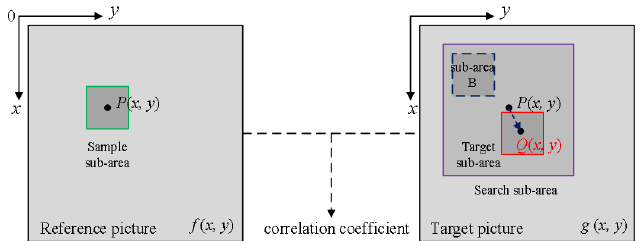
Figure 1. Calculation procedure of Digital Speckle Correlation